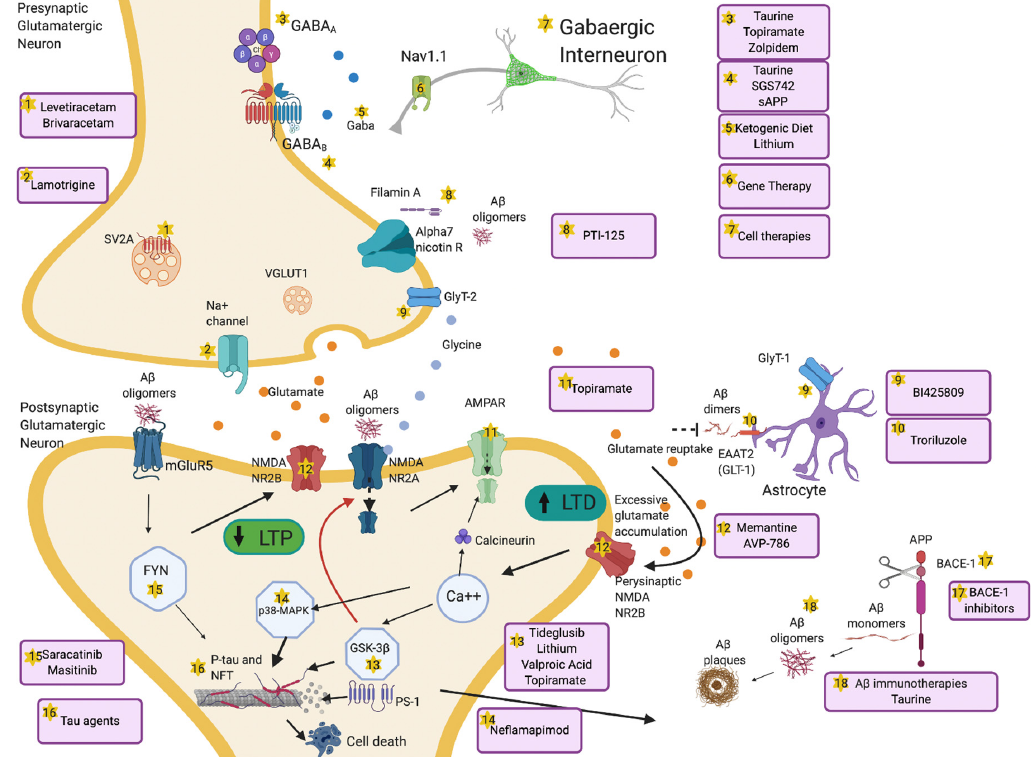
Figure 2. Overview of mechanisms and therapeutic targets of hyperexcitability in AD. A β dimers block glutamate reuptake by astrocytes through glutamate transporter-1 (GLT-1) receptors. This causes increased glutamate levels in the synaptic cleft, activation of perisynaptic N-methyl-D-aspartate (NMDA) 2B receptors, increased Ca++ influx, α -amino-3-hydroxy-5-methyl-4-isoxazolepropionic acid (AMPA) receptors internalization and activation of glycogen synthase kinase 3 beta (GSK-3 β ) and p38 mitogen-activated protein kinase (p38-MAPK) pathways. These pathologic cascades lead to abnormal tau phosphorylation and neurodegeneration. Long-term potentiation (LTP) is reduced and long-term depression (LTD) increases. A β oligomers interact pre- and postsynaptically with alpha-7 nicotinic receptors (alpha7-nAChRs), metabotropic glutamate receptors 5 (mGluR5s), and NMDA receptors. mGluR5 activates Fyn-mediated neurodegenerative changes. Increased excitation